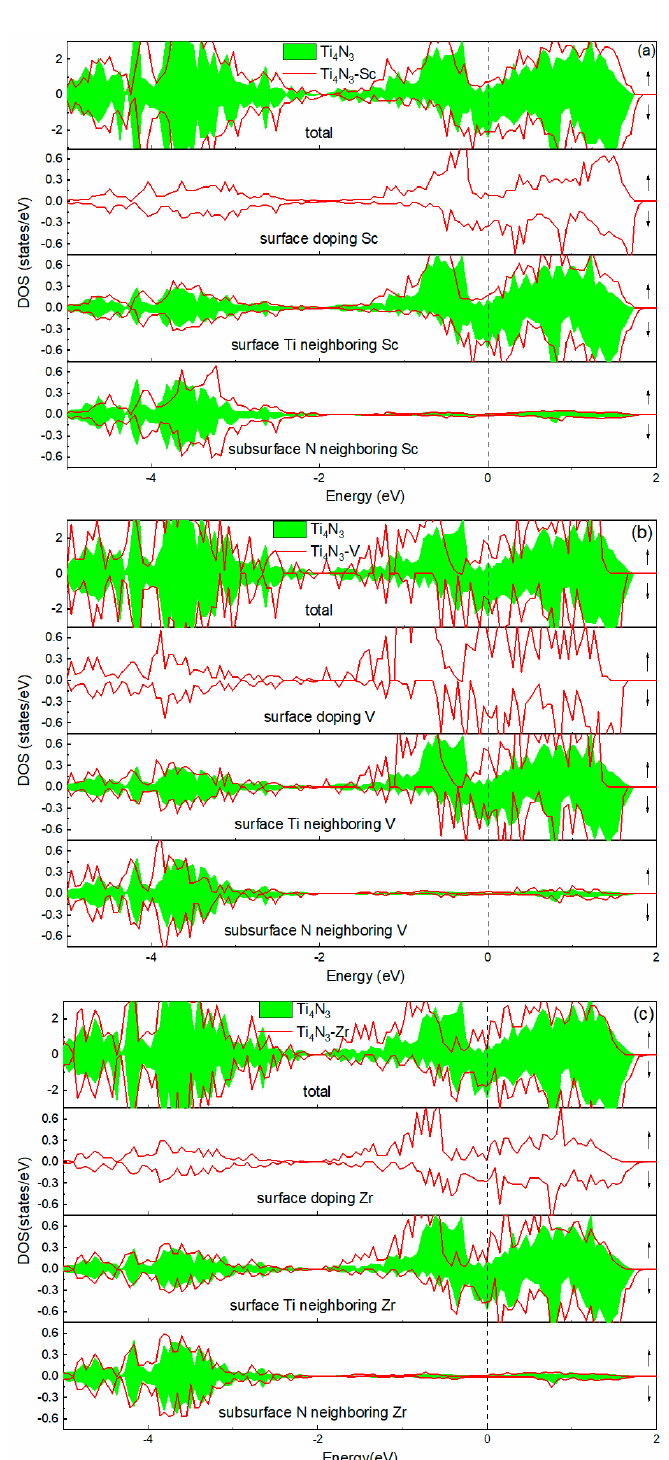
Figure 8. The TDOS and PDOS of transition metal ( a ) Sc, ( b ) V and ( c ) Zr doped Ti 4 N 3 nanosheet. ↑ and ↓ indicate the spin-up and spin-down orbitals, respectively. The Fermi level (dashed vertical line) is set to zero. The TDOS is transited to a primitive cell.